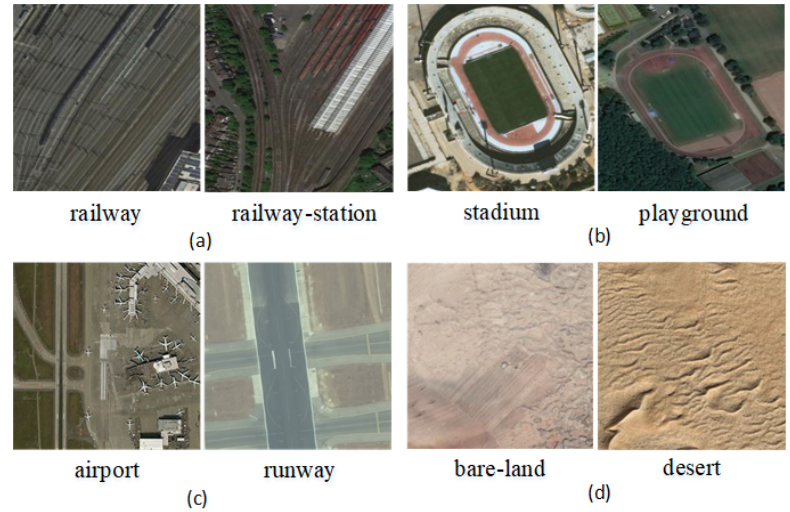
Figure 9. Larger interclass similarity. ( a ) Similar structures between different categories. ( b ) Similar objects between different categories. ( c ) Similar background between different categories. ( d ) Similar textures between different categories.